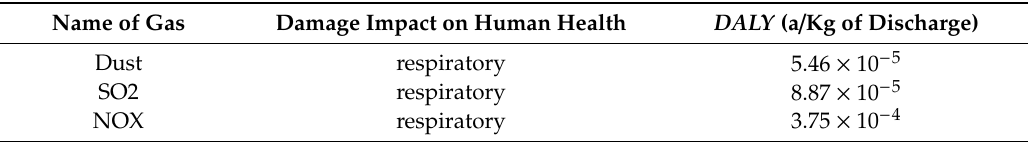
Table 8. DALY data of exhaust gas emission emissions in this article [32]. Name of